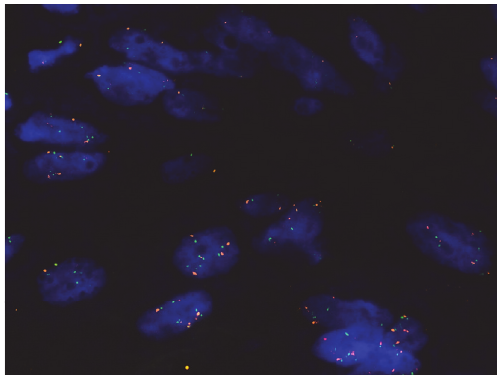
Figure 6: FISH analysis of resected abdominal mass: dual color probe (ZytoLight KRAS/CEN 12), demonstrating polysomy and isochromosome 12p (CEN 12: red; KRAS: green); magnification